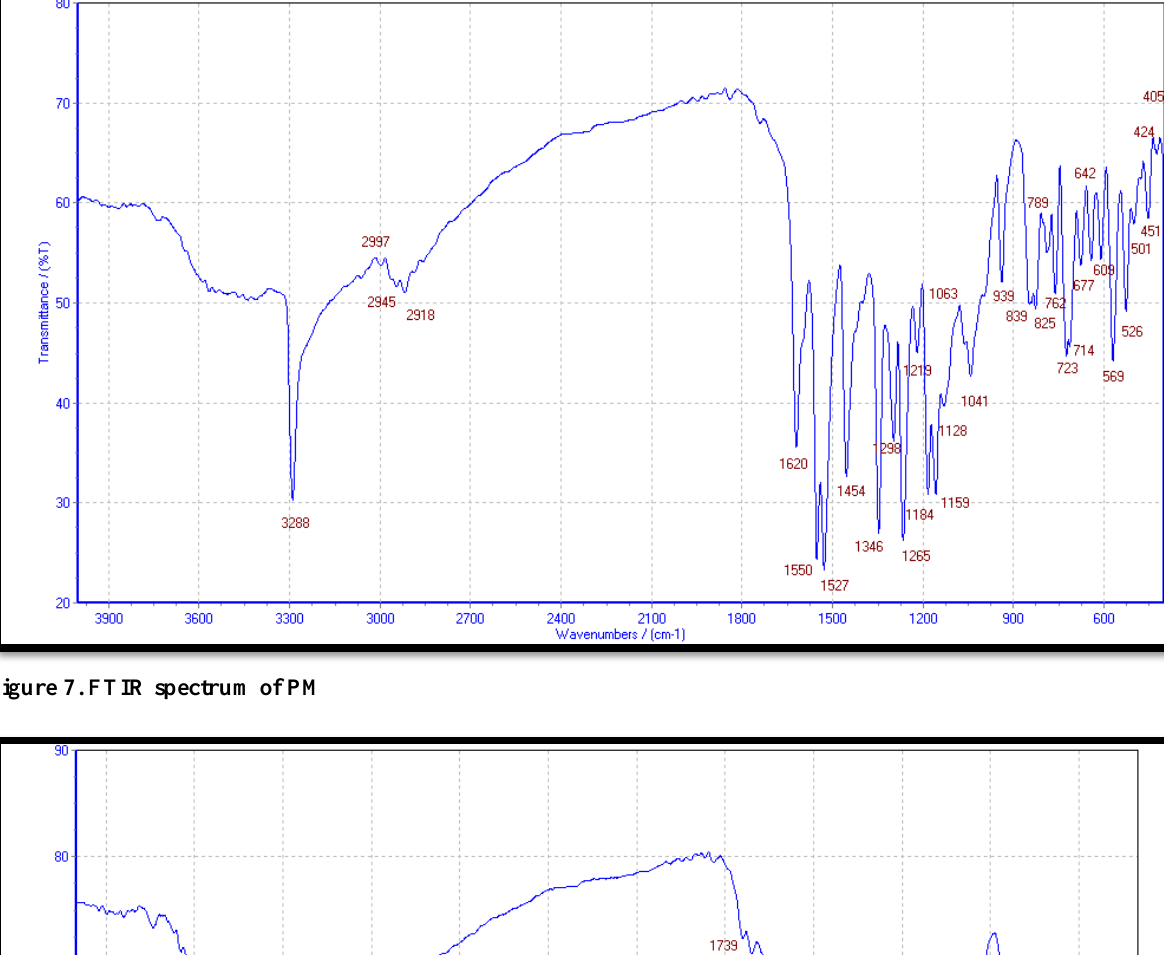
Figure 7. FTIR spectrum of PM